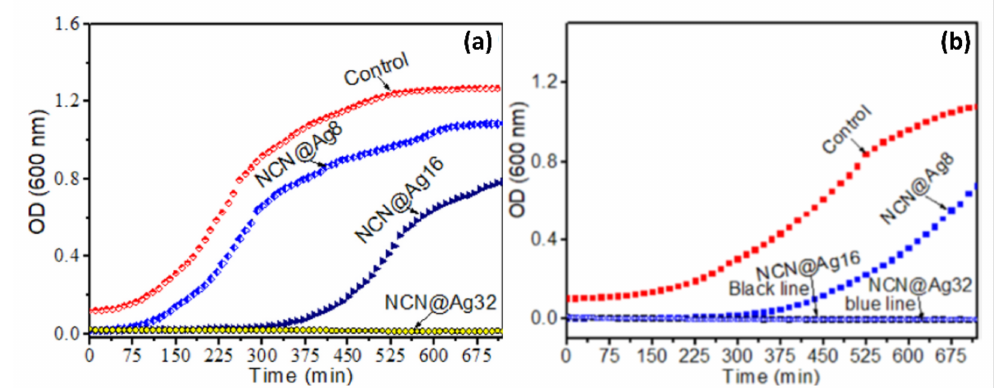
Figure 6. ( a ) Growth profiles of wild-type E. coli and ( b ) of MDR E. coli strains in the presence of control and various concentration of NCN@Ag NPs (adapted with permission from reference